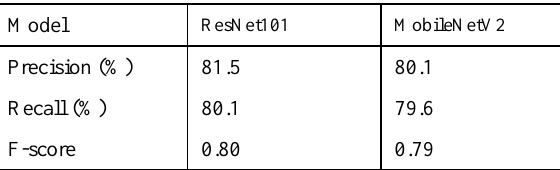
Table 8. Accuracy comparison of flood area mapping